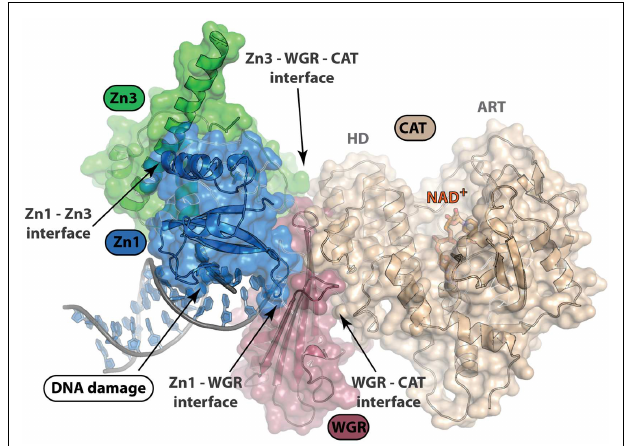
FIGURE 4 | Structure of PARP-1 in complex with DNA damage . PARP-1 binds DNA damage and activates catalytic activity nearly 500-fold. Only four of the six domains of PARP-1 (Zn1, Zn3,WGR, and CAT) are essential for DNA-dependent PARP-1 activation.This structure depicts complex formation and protein–protein interactions between domains upon DNA damage recognition (PDB ID: 4DQY). Disruption of these interdomain protein interfaces could be of interest in selective, allosteric targeting of PARP-1. An understanding of the arrangement of PARP-1 domain architecture in the absence of DNA damage recognition will be important for rational drug design efforts targeting protein